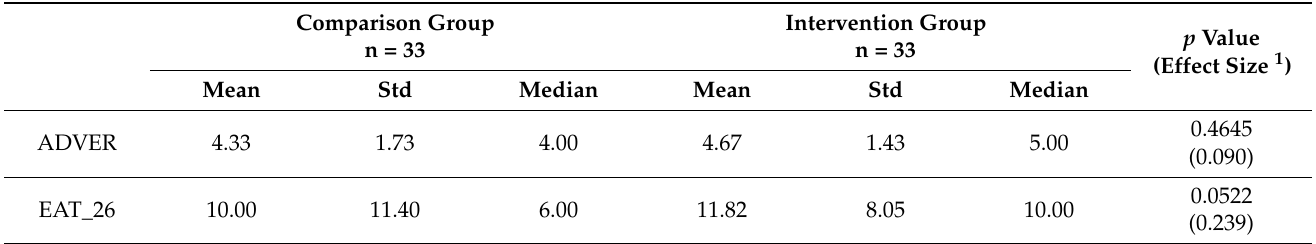
Table 4. Baseline differences between facilitators and comparisons in non-parametric outcome measures. Comparison